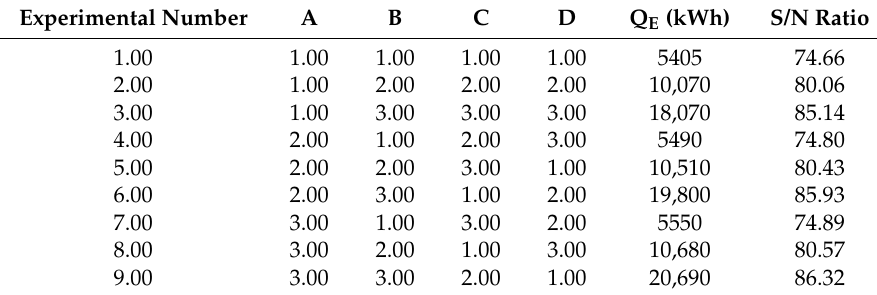
Table 11. SN ratio for each case in the trial experiment.